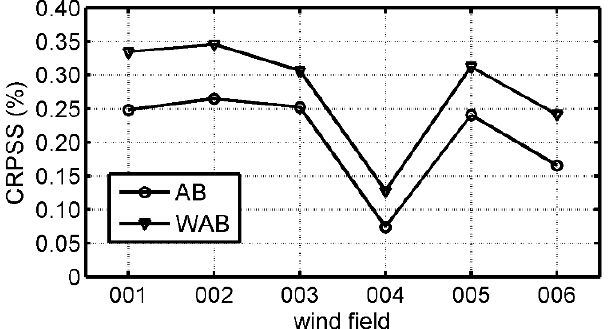
Figure 5. Continuous ranked probability skill ( CRPS ) score in all tested wind farms, with a comparison between average bias correction (AB) and weather adapted bias correction (WAB).